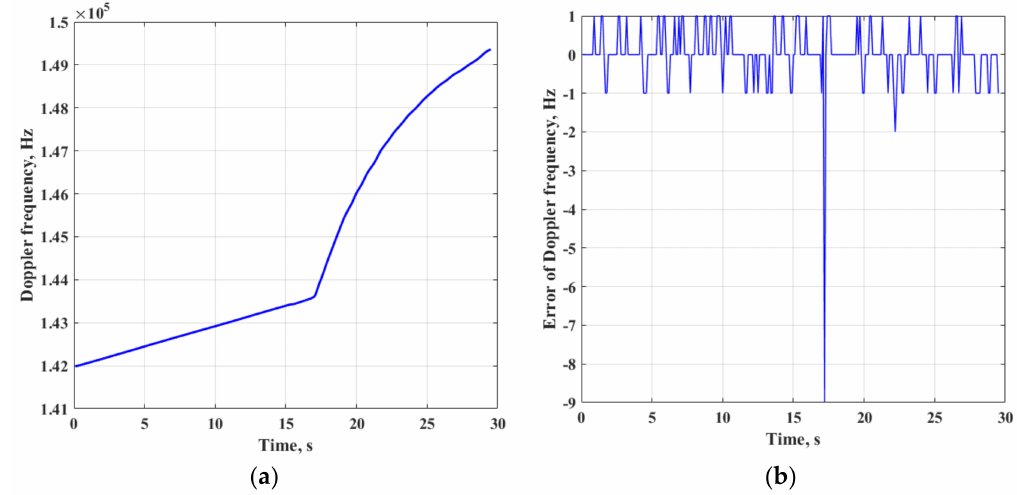
Figure 21. One estimation trial of an IFR tracking approach for parachute deployment at CNR = 29 dB-Hz: ( a ) Doppler frequency; ( b ) Doppler frequency errors.